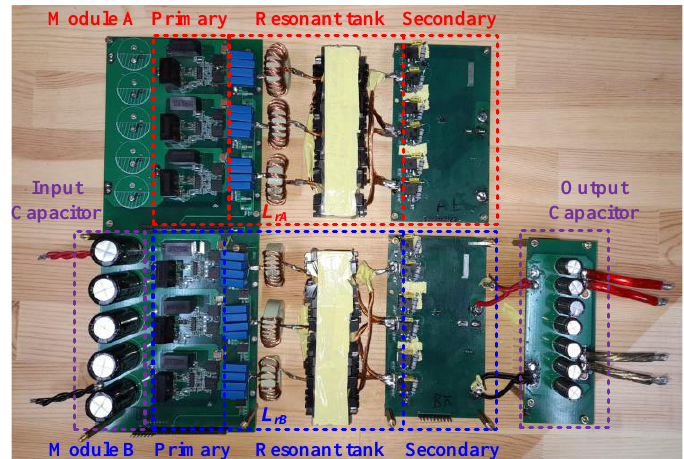
Figure 18. 2.4 kW experimental setup. Table 2. Summary of components.